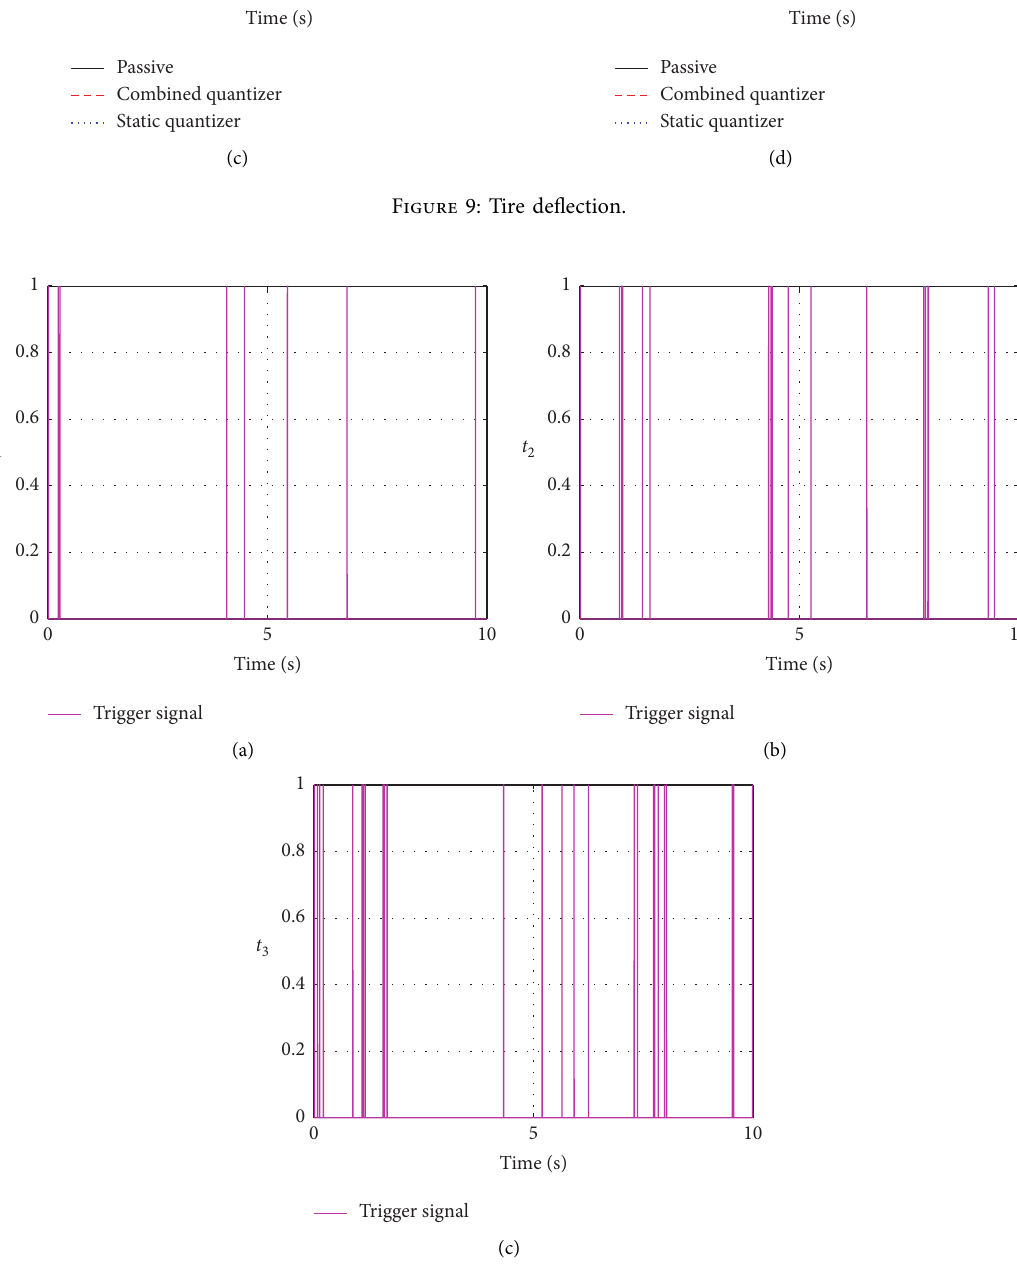
Figure 10: Trigger